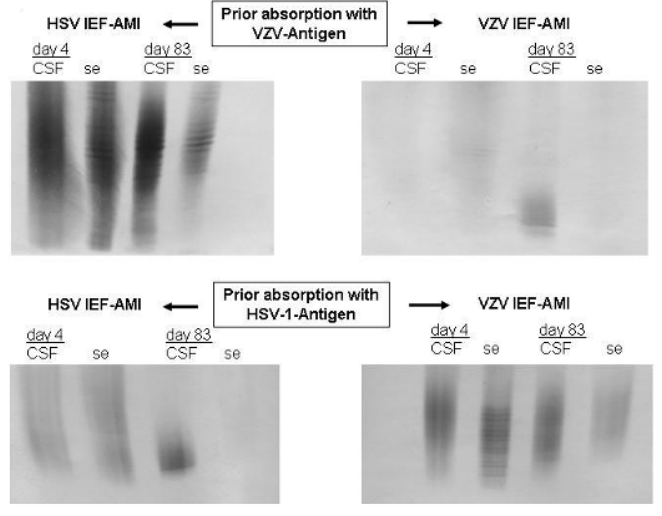
Figure 2 Patient 1. Results of cross absorption tests of cerebrospinal fluid (CSF) / serum (se)-pairs prior to isoelectric focusing of cerebrospinal fluid (CSF) and serum, adjusted to the same total IgG level with subsequent antigen-mediated immunoblot (IEF-AMI) on to nylon membranes coated with HSV-1- or VZV-antigen; day = of patient’s hospital